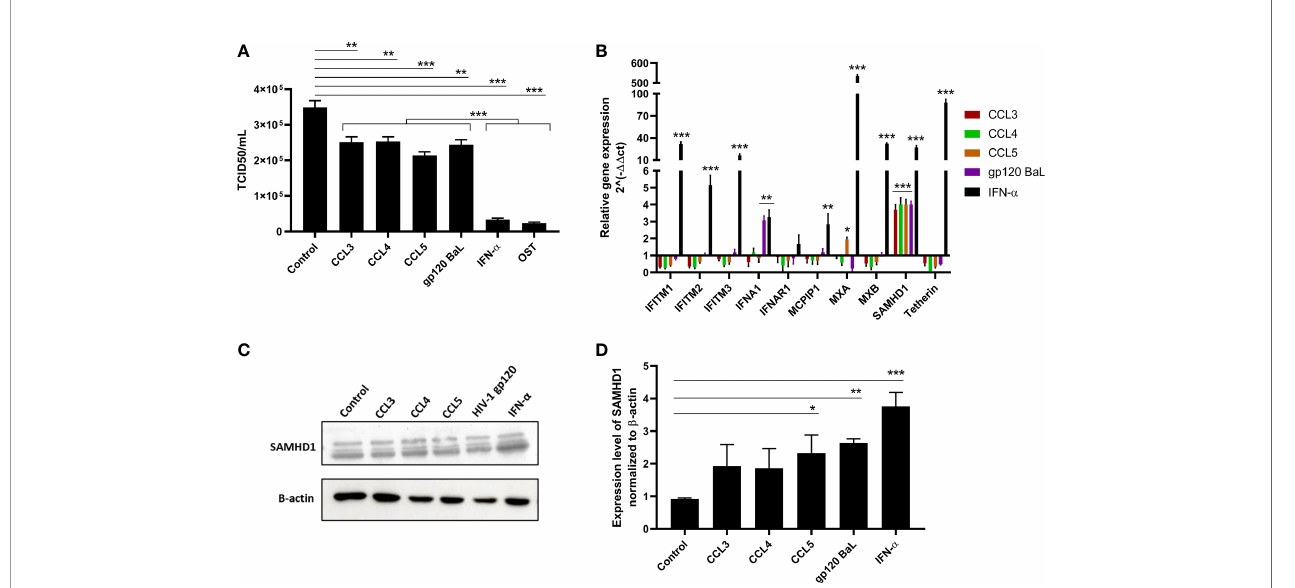
FIGURE 1 | CCR5 receptor agonists inhibit in fl uenza A replication and enhance transcriptional and protein levels of SAMHD1. (A) A549 cells were exposed to CCL3 (30 ng/mL), CCL4 (15 ng/mL), CCL5 (15 ng/mL) or HIV-1 gp120 Bal (5 μg/mL); IFN- a (10 ng/mL) and OST (0.5 μg/mL) were used as positive control. After 24 hours, cells were infected with in fl uenza A virus at MOI 2 for 1h, and the supernatant was harvested at 24 hpi. The viral titer was evaluated by TCID 50 assays. (B) For transcriptional analysis, total RNA of A549 cells exposed to agonists for 24 hours was extracted and the relative expression of restriction factors was determined using customized RT² Pro fi ler PCR Array. Analysis for relative gene expression was performed using the 2^(- DD CT) method, with GAPDH as reference gene. (C, D) Protein expression of SAMHD1 was evaluated by western blot assays using b -actin as a housekeeping protein; bands were analyzed by densitometry using the ImageJ software 1.5.0, with (D) representing three blot assays. The basal levels of SAMHD1 protein are shown in A549 cells (control), exposed to medium only. Data were obtained from 3 independent experiments with technical duplicates. *p < 0.05, **p < 0.01 and ***p <